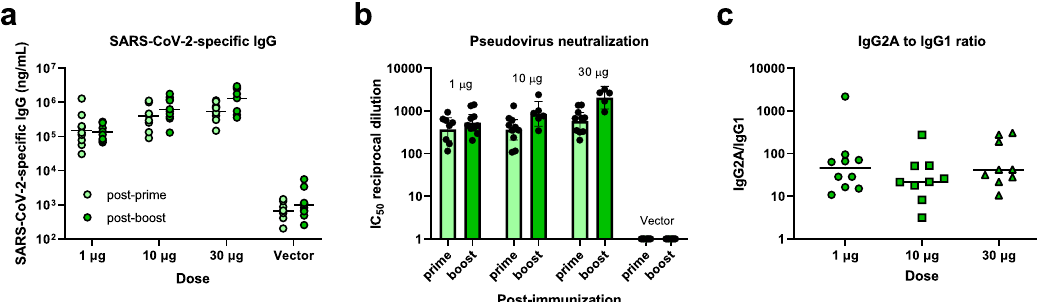
Fig. 2 Immunogenicity of SARS-CoV-2 D614G saRNA/NLC vaccine after prime or prime-boost immunization of C57BL/6J mice. a Serum SARS-CoV-2 spike protein-binding IgG. Horizontal lines show geometric mean. b Serum SARS-CoV-2 neutralizing antibodies against the original Wuhan strain. Results show geometric mean and 95% con fi dence interval. c Serum SARS-CoV-2 spike protein-binding IgG1 versus IgG2a indicates a strong Th1-biased response. Horizontal lines show median. The vector control represents mice injected with 10 μ g of NLC- complexed saRNA expressing the non-immunogenic secreted embryonic alkaline phosphatase gene. n = 10 mice per